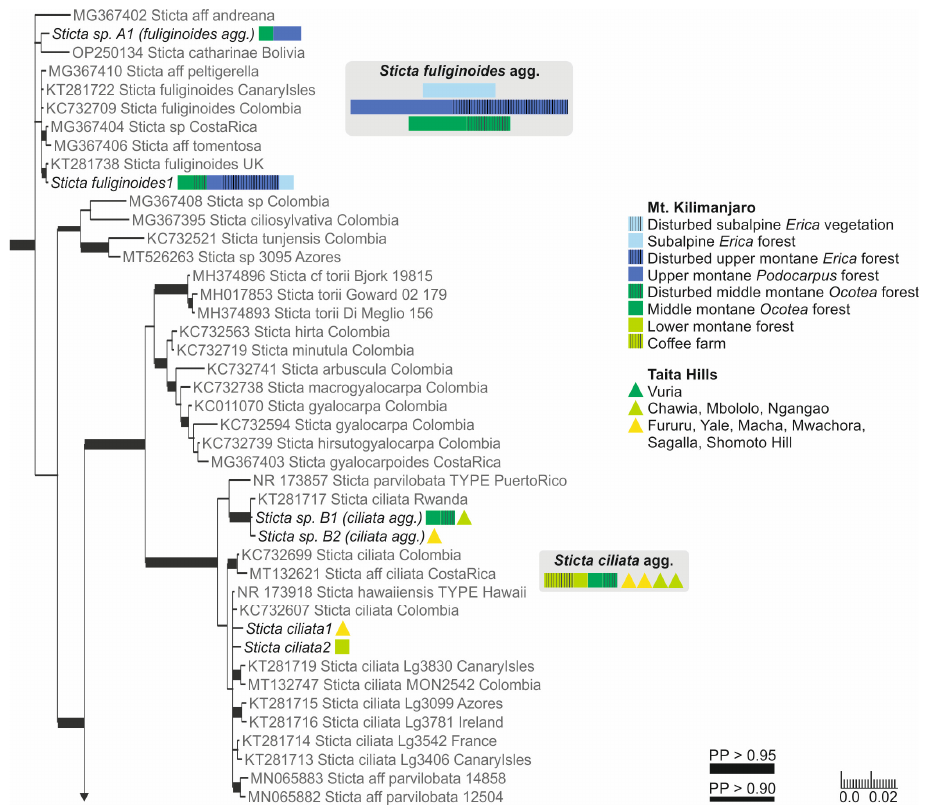
Figure 3. Clades with Sticta fuliginoides , S. ciliata, Sticta sp. A, and Sticta sp. B of the Bayesian tree of the genus Sticta based on the nuITS marker region (Figure S1C). The colored polygons (rectangle, triangle) in the tree show the distribution of the ITS variants in the studied regions and ecosystem types: On Mt. Kilimanjaro, the different habitats are indicated by color and grid; the width of the rectangle indicate the number of sample plots in which the taxon was present in each ecosystem type (square = 1). In the Taita Hills, each triangle indicates presence in one forest fragment. The grey boxes show the total abundance and distribution of the species, also including the data from unse- quenced specimens. Stronger support (PP > 0.9) for a clade is indicated with a thicker branch. The scale refers to nucleotide substitutions per site.